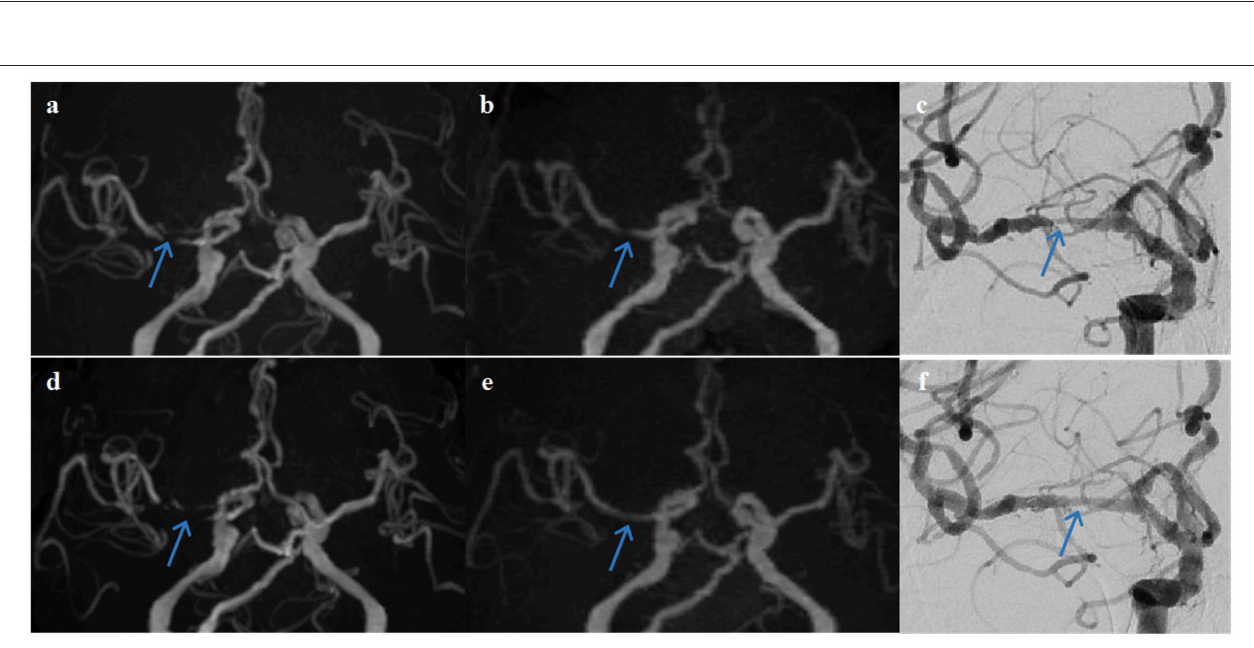
Frontiers in Cardiovascular Medicine |